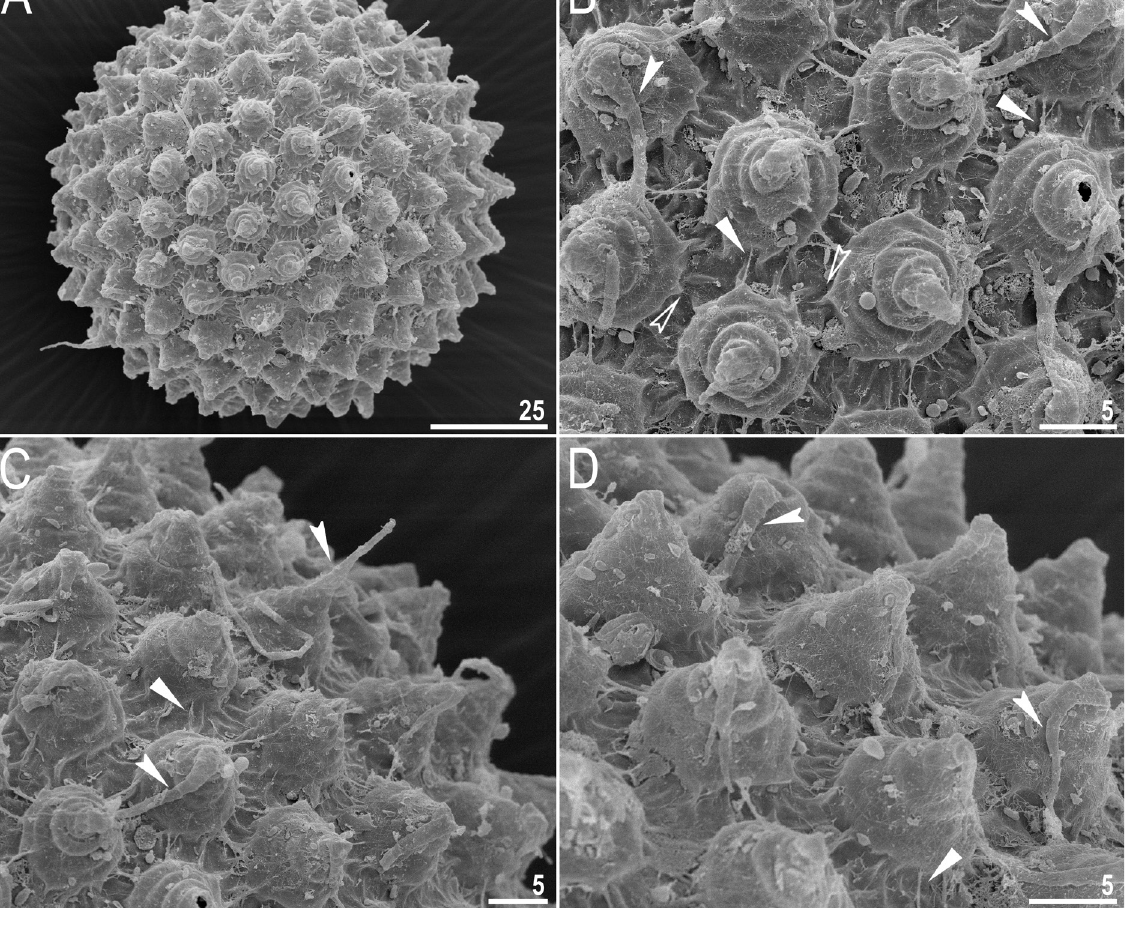
Fig. 22. Tenuibiotus voronkovi (Tumanov, 2007), egg chorion morphology seen in SEM. A . Entire egg. B – D . Details of the egg processes and surface between them. Filled flat arrowheads indicate thickenings/ striae on the surface between processes, filled indented arrowheads indicate elongated and flexible apices of egg processes which are often folded, whereas empty indented arrowheads indicate micro pores on the chorion surface between processes. Scale bars in